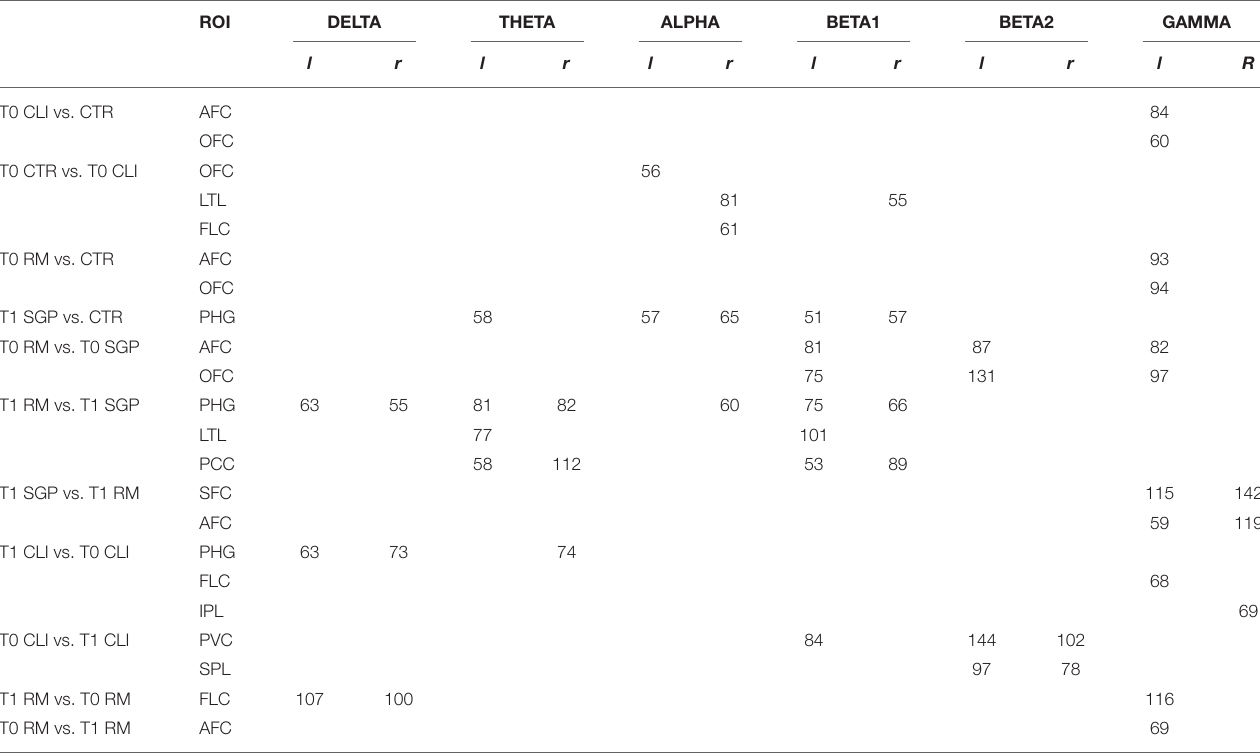
TABLE 4 | Regions of significant activation differences and relative cluster extent. ROI DELTA THETA ALPHA BETA1 BETA2 GAMMA l